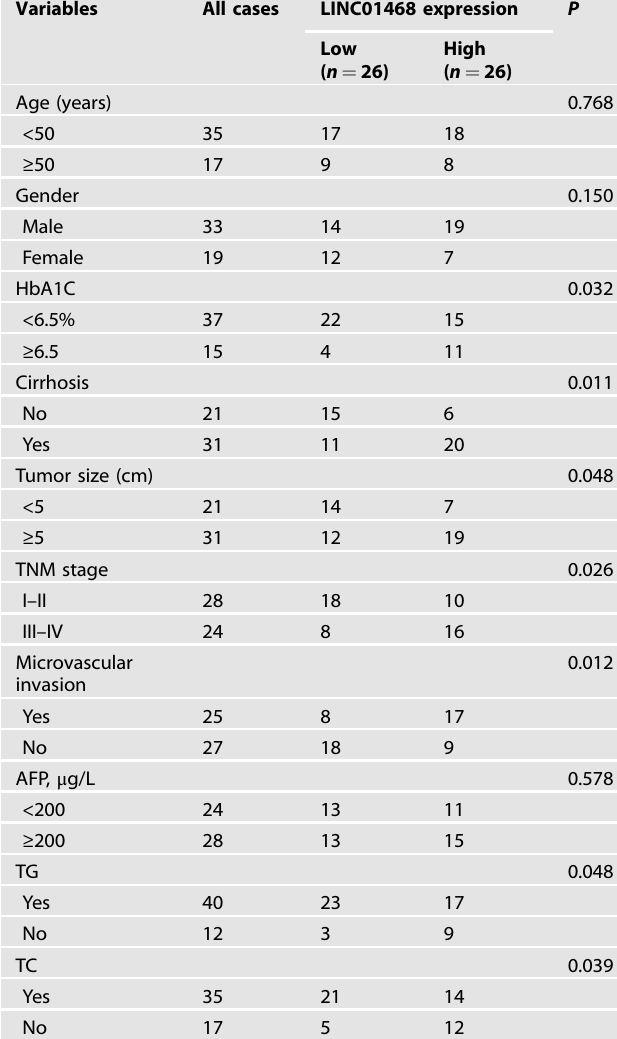
Table 1. Relationship between LINC01468 and clinicopathological parameters in 52 HCC